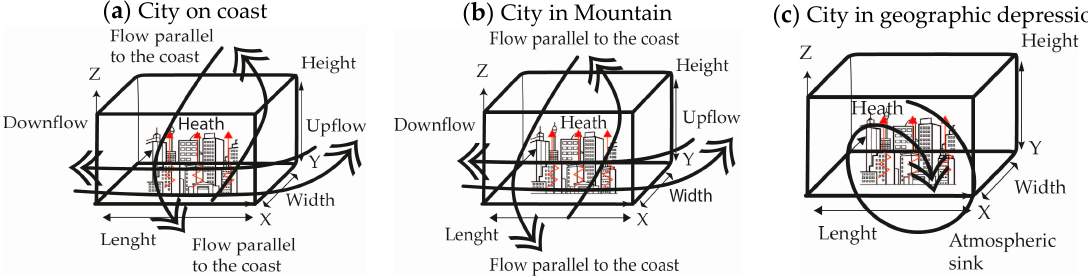
Figure 6. Atmosphere cell model for wind flow dynamics.